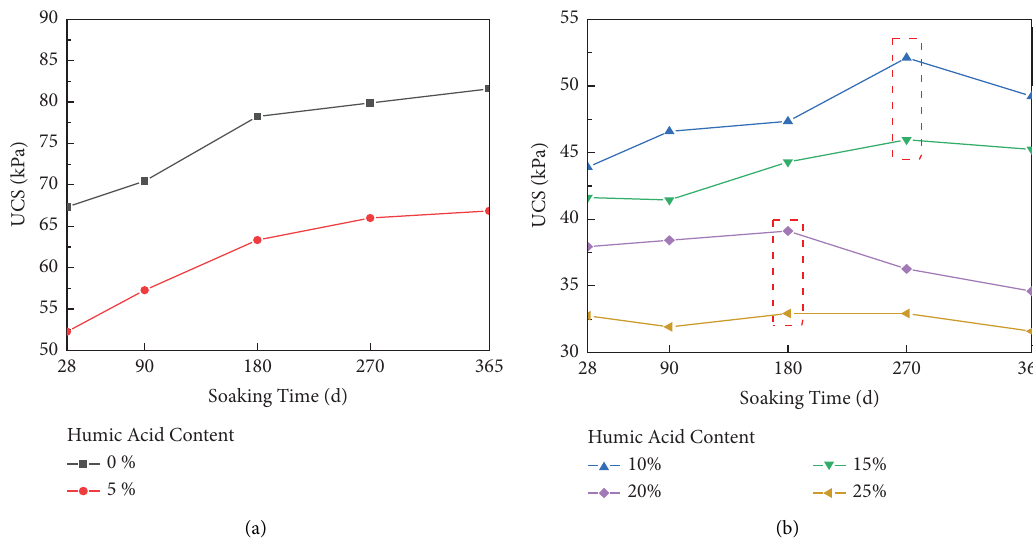
Figure 10: Relationship curve between sample UCS and soaking age (pH value of FA solution: 5.0).